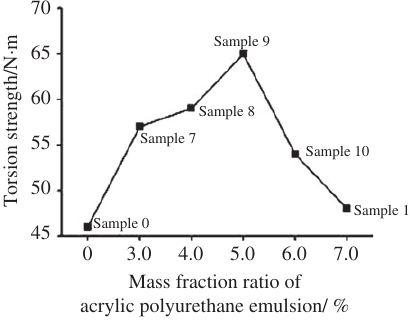
Figure 4 Comparative torsion strength value of the GFRP-anchor body as a function of acrylic polyurethane emulsion content.